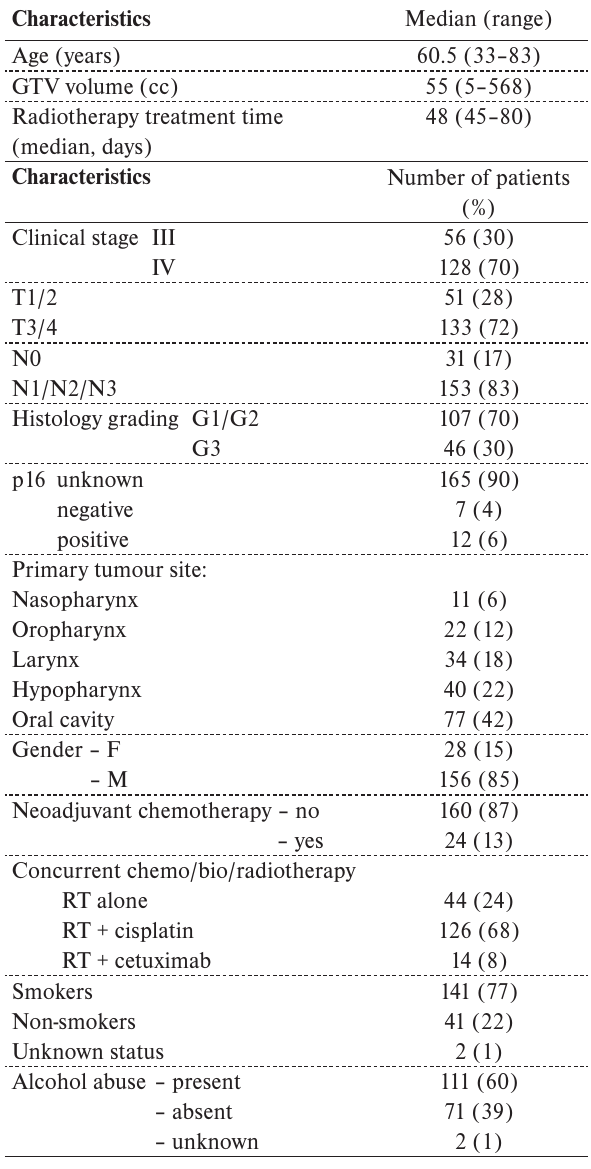
Table 1. Patients, tumour and treatment characteristics. Median (range) is reported for continuous and counts (percentage) for categorical